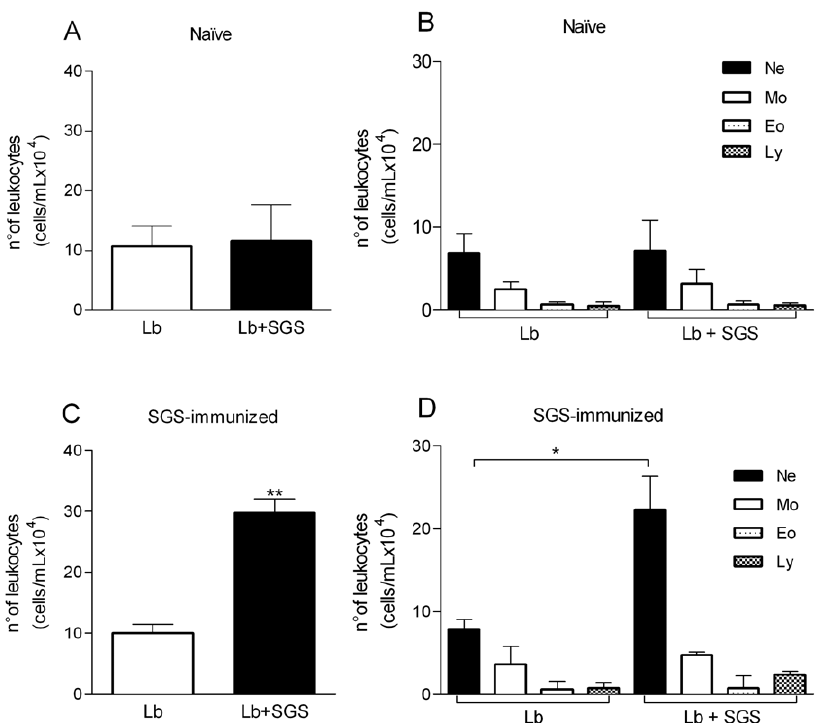
Figure 5. Leukocyte recruitment in air pouch exudates in response to L.braziliensis parasites and L.intermedia saliva. BALB/c mice (five to six per group) received three immunizations with L. intermedia SGS. Fifteen days after the last immunization, air pouches were raised in naı¨ve mice and in mice immunized with L. intermedia SGS. Air pouches were inoculated with L. braziliensis alone (Lb) or with L. braziliensis + L. intermedia saliva (Lb + SGS). Exudates were collected twelve hours later. Leukocytes were enumerated microscopically. (A) Total number of leukocytes accumulated in air pouches and (B) total number of neutrophils, monocytes, eosinophils, and lymphocytes accumulated in air pouches of naı¨ve mice. (C) Total number of leukocytes accumulated in air pouches and (D) total number of neutrophils, monocytes, eosinophils, and lymphocytes accumulated in air pouches of SGS-immunized mice The data shown are from a single experiment representative of three independent experiments. (* P , 0.05).